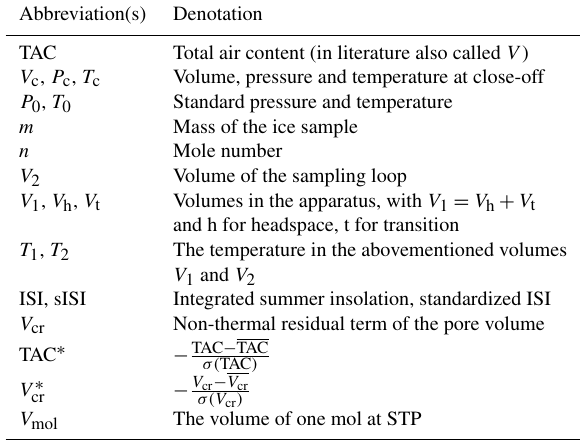
Table 1. List of abbreviations in the order in which they are first